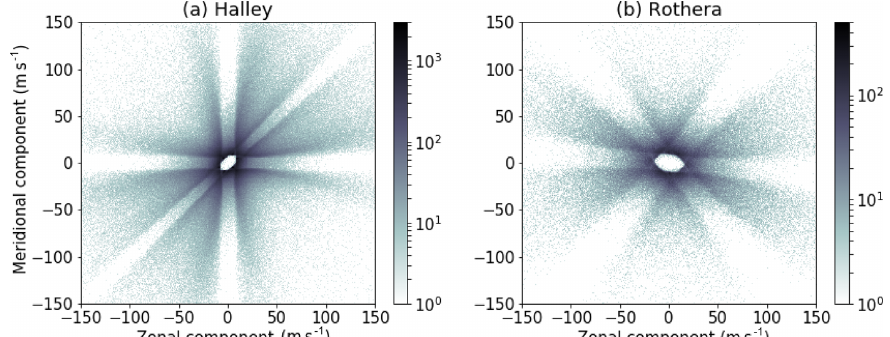
Figure 5. Two-dimensional density plots of wind velocity measurements with ellipse axial ratio R > 5. Data points from all altitudes are included. The data from both radars show qualitatively similar patterns which seem to be artefacts of the three-antenna arrangement and full correlation analysis measurement